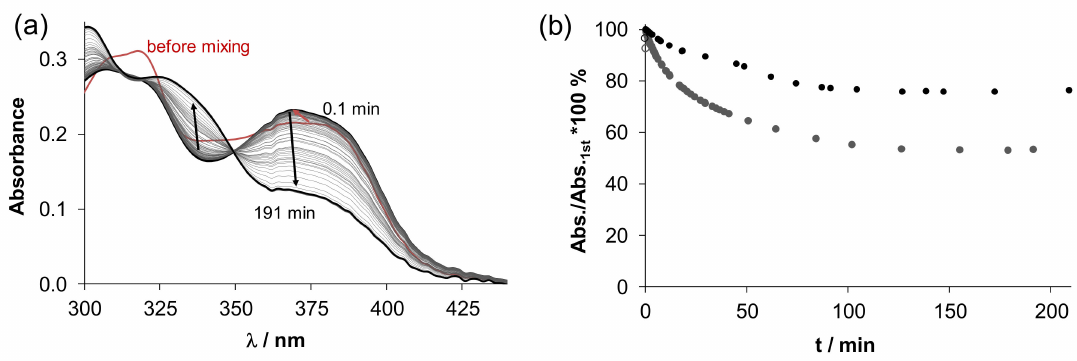
Figure 7. ( a ) Time-dependent UV / Vis absorption spectra of 2 in the presence of 50 equiv. glutathione (GSH) before (red line) and after mixing the reactants (black lines) in a tandem cuvette. ( b ) Absorbance values at 370 nm (grey dots) for 2 and at 376 nm (black dots)for 4 independent of time. Absorbance read from the first spectrum recorded after mixing is considered as 100%, the empty symbols denote the absorbance values measured before mixing (pH = 7.4 (50 mM HEPES); c complex = 25 µ M; c GSH = 1.25 mM; I = 0.1 M (KCl); t = 25 ◦ C). The measurement was done